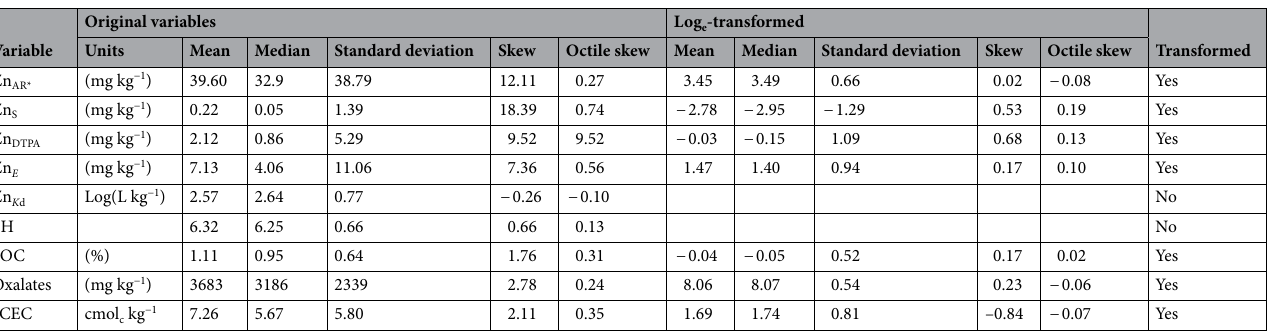
Table 2. Summary statistics of soil properties (n = 1600) proposed as predictors of Zn concentration in grain. *The subscripts AR, S, DTPA, K d and E denote the total (aqua regia extractable), soluble (calcium nitrate extractable), potentially available (DTPA extractable), the solid-solution distribution coefficient, and the isotopically exchangeable (isotopic dilution) fractions. SOC denotes soil organic carbon. eCEC denotes the effective cation exchange capacity. Oxalates denotes the sum of oxalate-extractable Fe, Al and Mn oxides.